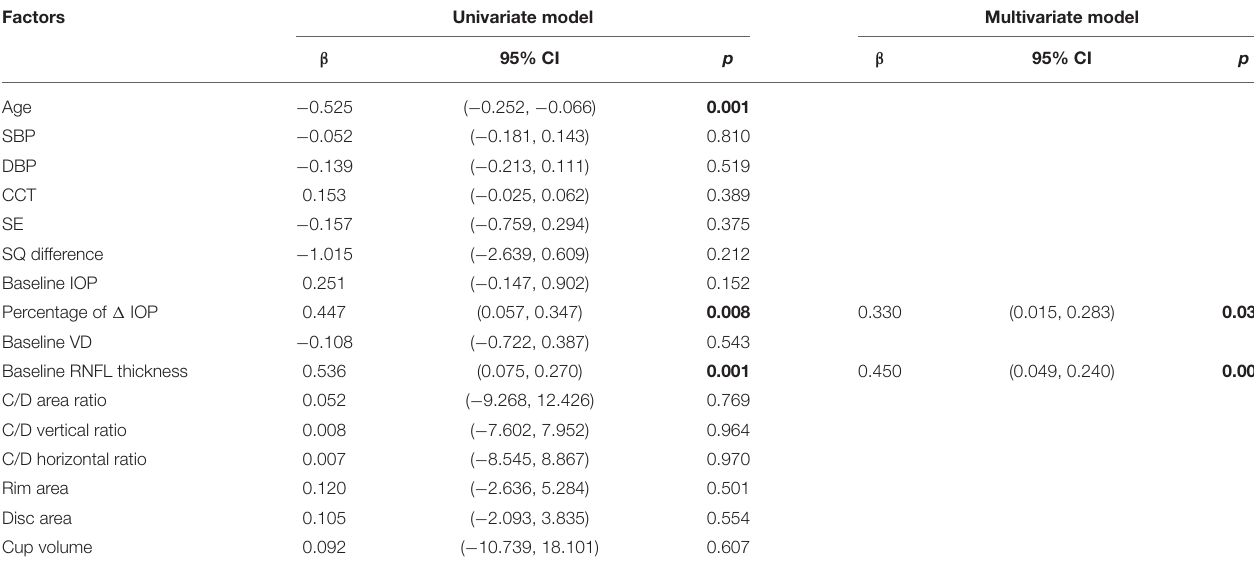
TABLE 4 | Factors associated with increase of peripapillary VD after treatment in linear regression analysis. Factors Univariate model Multivariate model